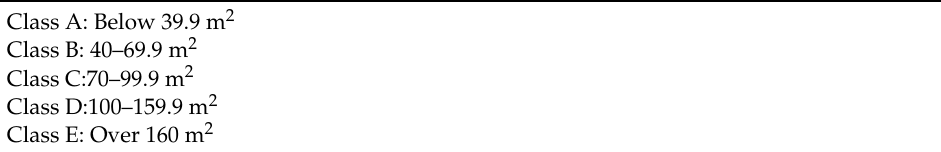
Table 1. Classification of private residential units of Rating and Valuation Department, Hong